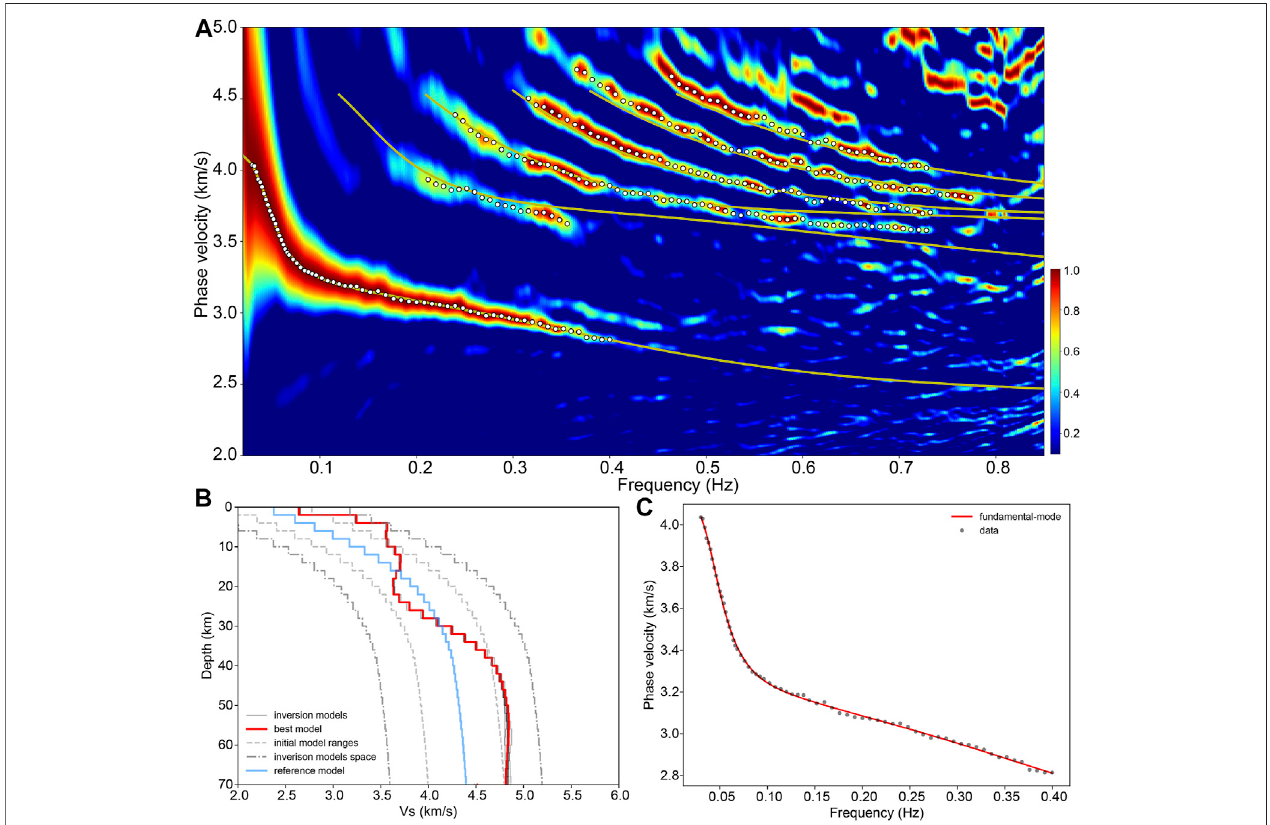
FIGURE 3 | Identi fi cation of the multimodal dispersion curves for array “ TH ” . (A) The F-J spectrogram of seismic array “ TH ” ; the yellow solid lines denote the theoretical multimodal dispersion curves corresponding to the fundamental-mode velocity model, and the white dotted lines denote the picked fundamental-mode and higher-modedispersioncurves. (B) Thefundamental-modedispersioncurveinversionresults;thebluelineisthereferencevelocitymodel;theredandblacklinesarethe fi rst ten well- fi tting models obtained from inverting the fundamental-mode dispersion curve; the red line denotes the best- fi tting inversion model with the smallest objectivefunctionvalue;thegraydashedlinelinesrepresenttherangeoftheinitialmodels.thegraydash-dottedlinesrepresenttheinversionmodelspace. (C) The fi tting result of the fundamental-mode velocity model; the black points are the picked fundamental-mode dispersion points, and the red line denotes the theoretical dispersion curve corresponding to the fundamental-mode velocity